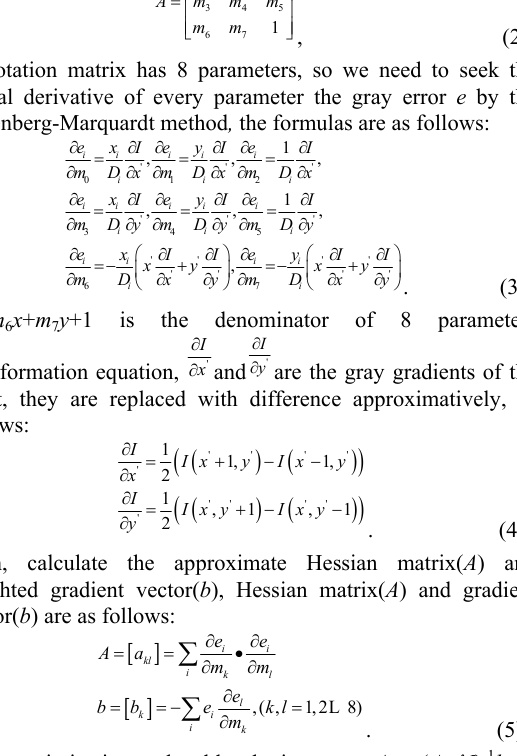
" A " is optimization updated by the increment Δ m =( A+ λ I ) -1 b ,